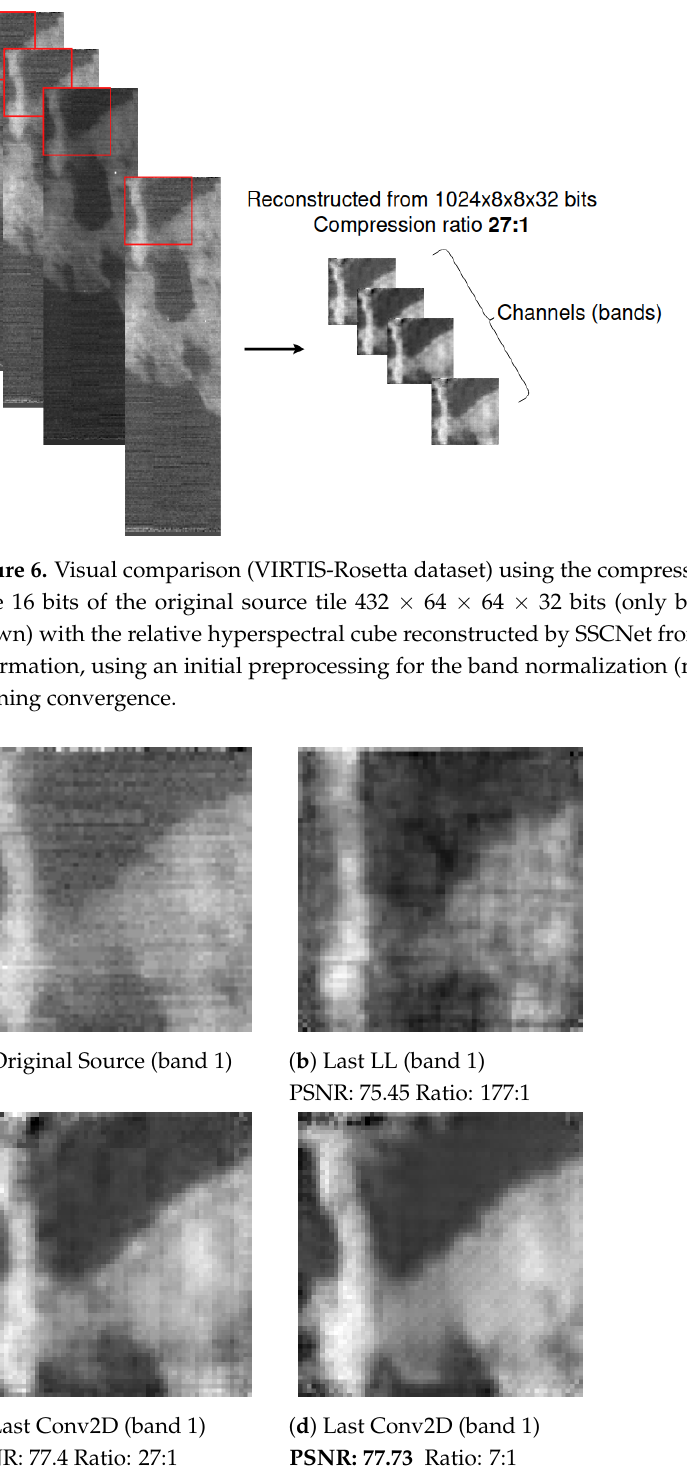
Figure 7. Comparison using a compression ratio 177:1 ( b ) and 27:1 ( c ) and data type 32 bits (over VIRTIS-Rosetta dataset) of the original source tile ( a ). In ( b ), we show the image reconstructed (band 1) using SSCNet with the last linear layer applied and in ( c ) the SSCNet using the last 2D convolution layer. In ( d ), we use SSCNet with a compression ratio 7:1 showing improvements in terms of PSNR than the others